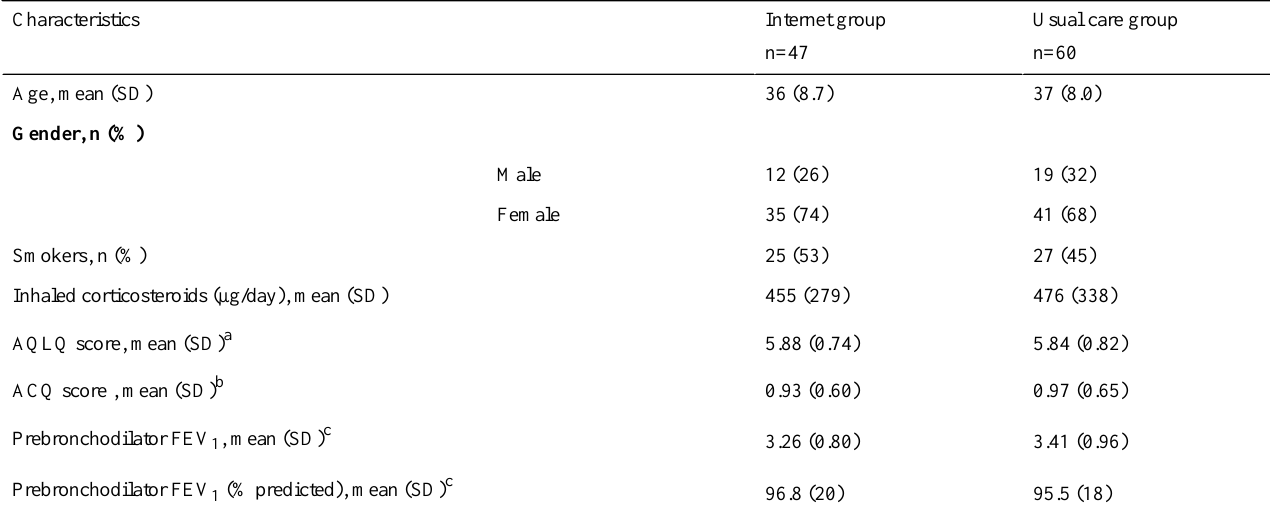
Table 3. Baseline characteristics.